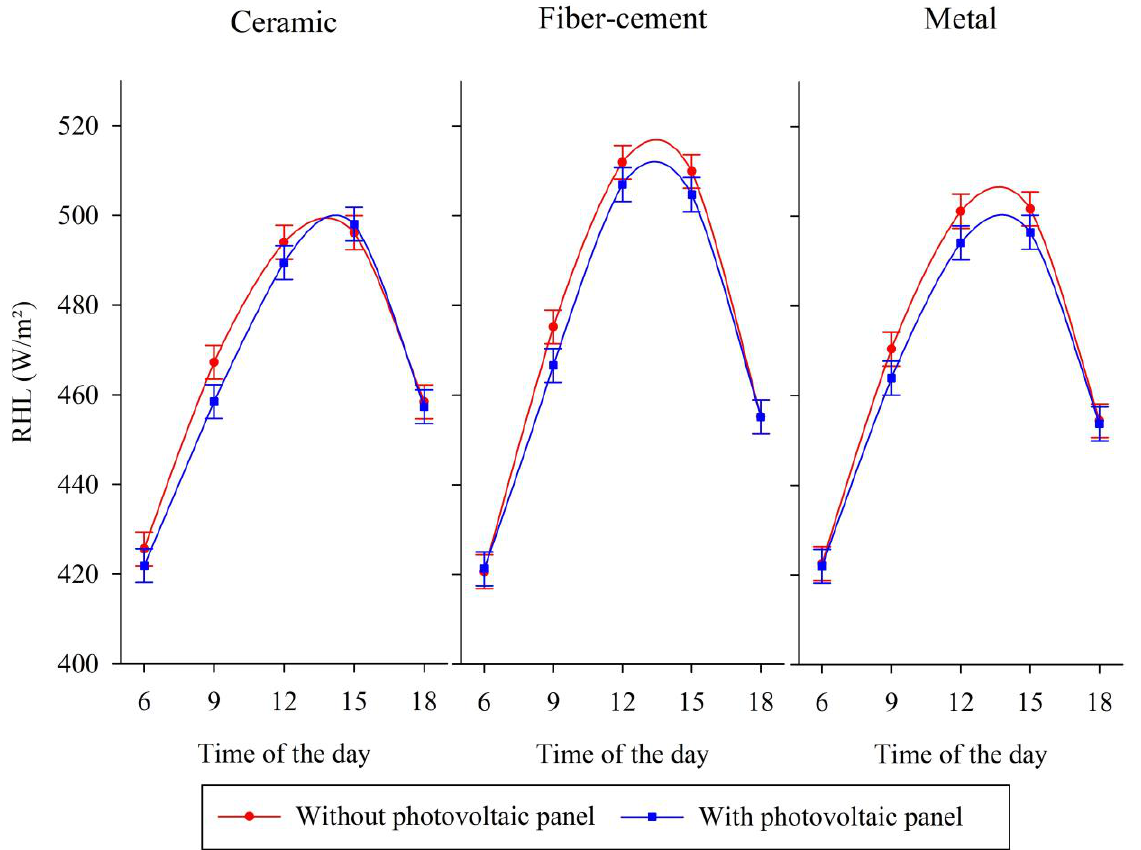
Figure 9. Behavior of the thermal radiation load (RHL) for the prototypes with the three types of tiles (ceramic, fiber-cement, and metallic) with and without the photovoltaic panel.